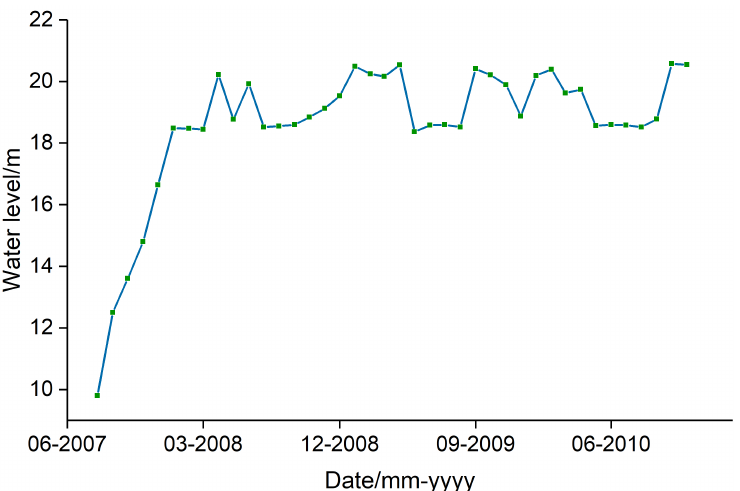
Figure 9. The upstream water level of the dam from August 2007 to November